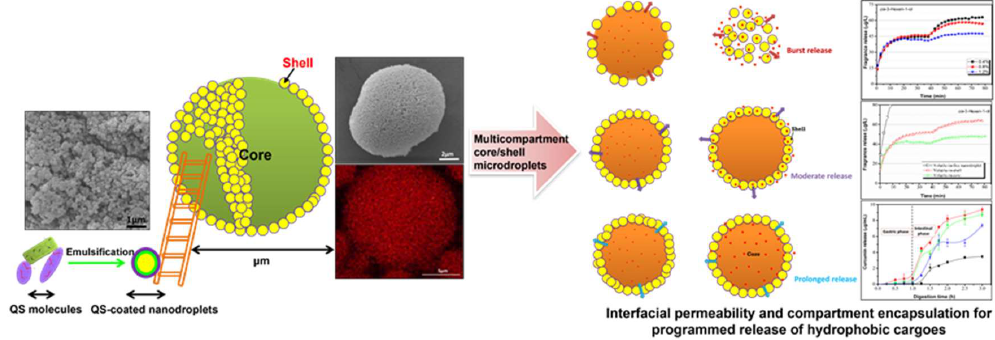
Figure 3. Schematic illustration of the mechanism for programmed release of hydrophobic cargoes from the multicompartment microdroplets stabilized by Quillaja saponin (QS)-coated nanodroplets. Images were reproduced with permission from [87].